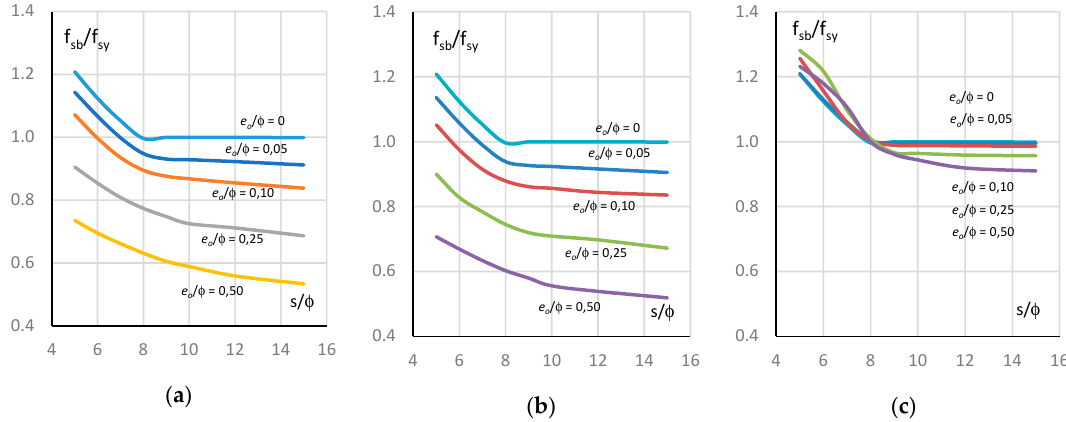
Figure 8. Normalized buckling resistance—slenderness curve for: ( a ) bending deformation (MD), ( b ) compression deformation (ND) and ( c ) shear deformation (VD).